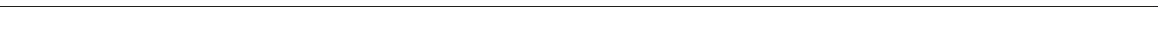
Fig. 7 Histopathology. Representative images of sections derived from the a brain (scale bar = 20 µ m), b thyroid gland (scale bar = 500 µ m), c adrenal gland (scale bar = 500 µ m), d liver (scale bar = 100 µ m), e – g kidney (in e , f : scale bar = 200 µ m; in g : scale bar = 100 µ m), h testis (scale bar = 500 µ m), and i lung (scale bar = 200 µ m) are shown on the left . Quanti fi cation of a proportion of animals bearing eosinophilic thalamic inclusions (indicated by arrows ), b median follicle size of the thyroid gland, c relative surface area covered by lipofuscin deposits within the adrenal gland, d number of hepatic microgranulomas (indicated by arrows ), e number of urinary casts in the kidney (indicated by arrows ), f number of hyaline changes in renal arterioles (indicated by arrows ), g the relative surface area on renal sections covered by tubular luminal space, h ratio of testicular seminiferous epithelium/lumen in seminiferous tubules, and i coverage of broncheoli-associated lymphoid tissues (BALT) in the lung (indicated by arrows ) are presented in panels on the right . Data in b are shown as median ± SEM and data in c – i are presented as mean ± SEM. Statistical analyses was performed using Fisher ’ s exact test for a or two-way ANOVA for b – i (young + AL: n = 16, young + EOD: n = 16, old + AL: n = 19, old + EOD: n = 20). AL ad libitum, EOD every-other-day